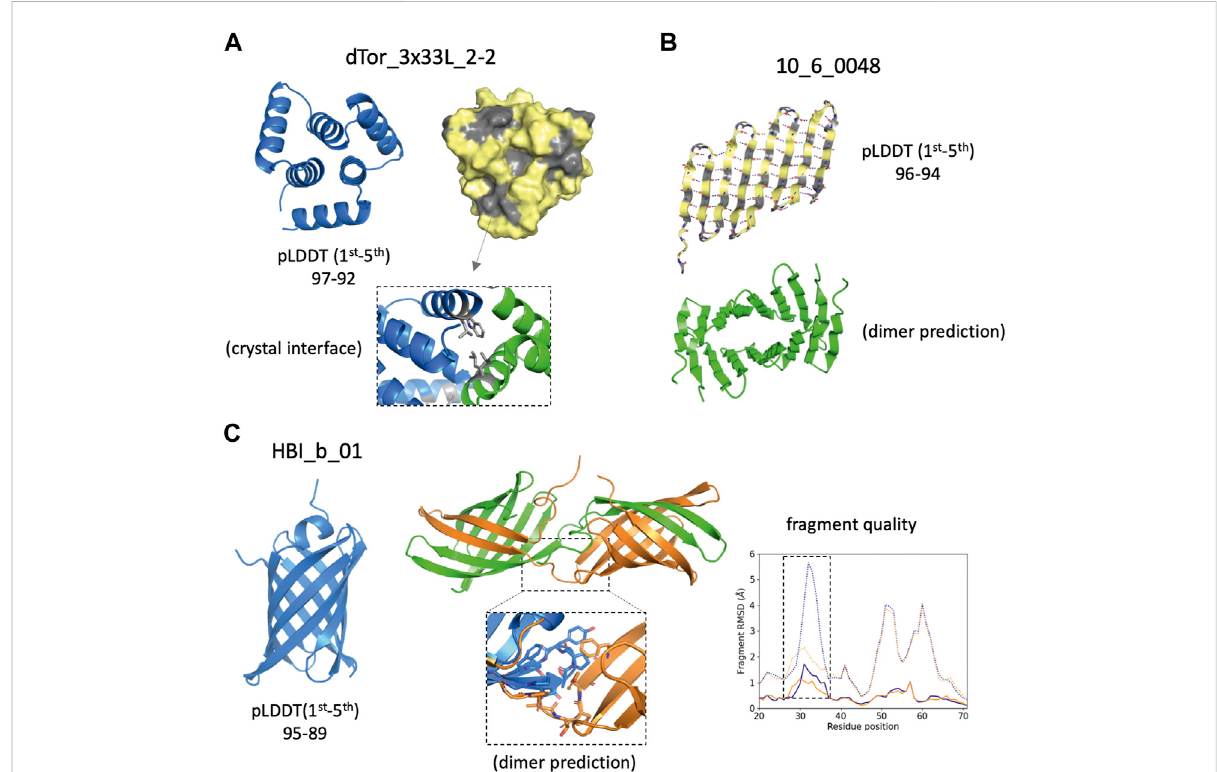
FIGURE 4 Design examples showing complementarity between AlphaFold predictions and other descriptors. (A) Cartoon ( left ) and surface ( right ) representationsofthetopAlphaFoldmodel,whichpresentssolvent-exposedhydrophobicpatches( ingray )favoringdimerizationasobservedinthe crystalstructure( bottom inset ). (B) TopAlphaFoldmodelofan unsuccessful β -barreldesign,forming analternative extended β -sheetthat duetothe pleatingof β -strandsformsalargehydrophobic( gray )andapolar( yellow )side.SuchstructureispronetoaggregationandAFpredictsoligomer interactions through the hydrophobic side. (C) Top AlphaFold model forms a β -barrel structure with high-con fi dence across all residues ( left ). A swapped dimer is predicted to form ( center ) due to a change in conformation on a β -hairpin loop ( bottom inset ). Fragment quality analysis ( right ) comparison between the monomer ( blue ) and dimer subunit ( orange ) indicates that two fragment quality descriptors (average fragment RMSD, dotted lines ; worst_rmsd_best_frag, solid lines ) for the β -hairpin loop ( dashed rectangle ) improve in the dimer